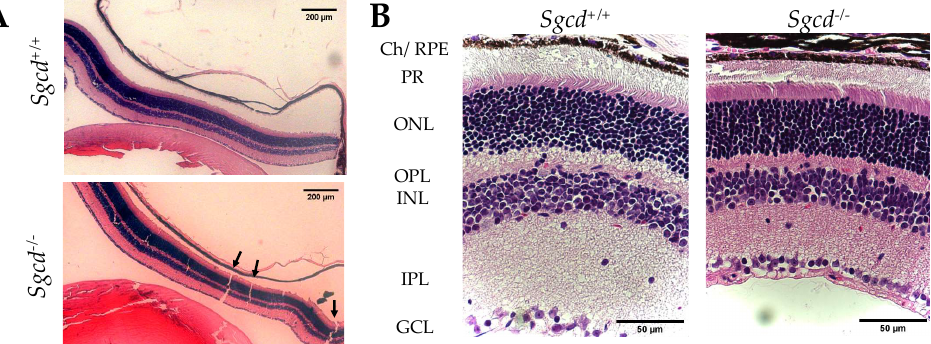
Figure 1. Retinal morphology of three-month-old Sgcd − / − and Sgcd +/+ mice. ( A ) Representative retinal cross-sections stained with hematoxylin and eosin (H&E) at 5× magnification. Black arrows point to regions of retinal tearing. ( B ) Representative retinal cross-sections stained with H&E at 20× magnification. Ch/RPE: Choroids, retinal pigmented epithelium; PR: photoreceptor layer; ONL: outer nuclear layer; OPL: outer plexiform layer; INL: inner nuclear layer; IPL: inner plexiform layer; GCL: ganglion cell layer. Table 1. Structural characteristics of three-month-old Sgcd +/+ and Sgcd − / − mice. 1 Characteristic Sgcd +/+ Sgcd – / – p -Value 1,2